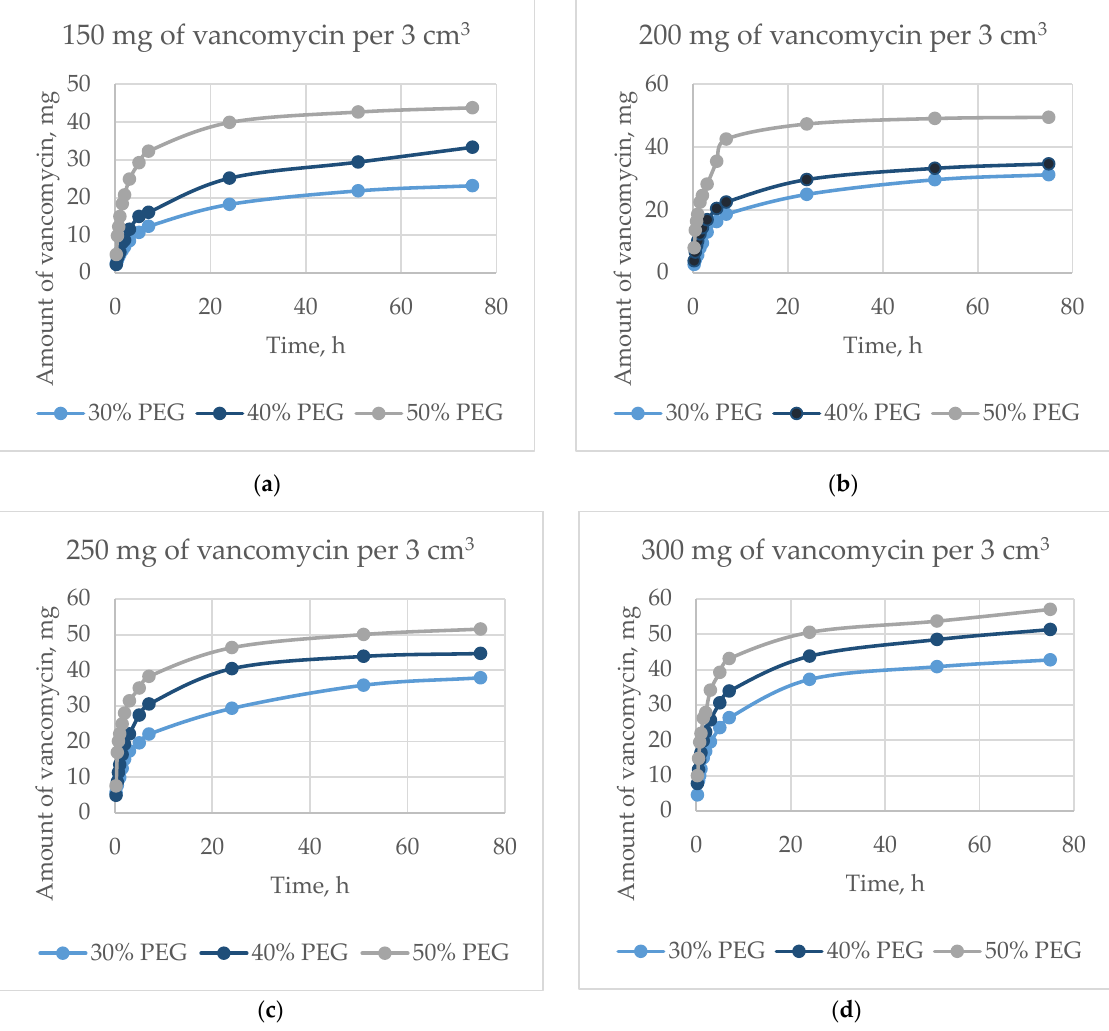
Figure 11. Dynamics of the release of vancomycin from the matrix at initial contents of ( a ) 150 mg,